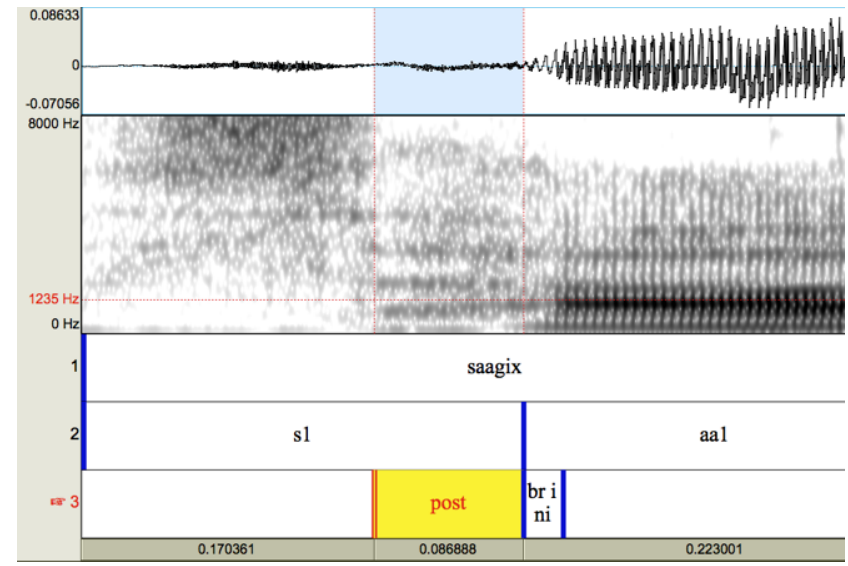
Figure 1: Post-aspiration in the word saagix ‘to swirl (smoke)’. ‘br ini’ = breathiness caused by preceding